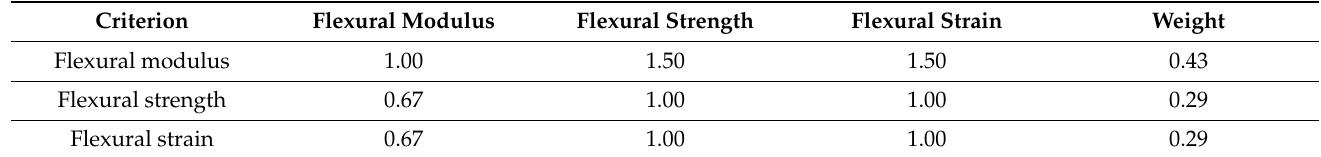
Table 10. The data on the paired comparison and the weights. Mechanical factors.